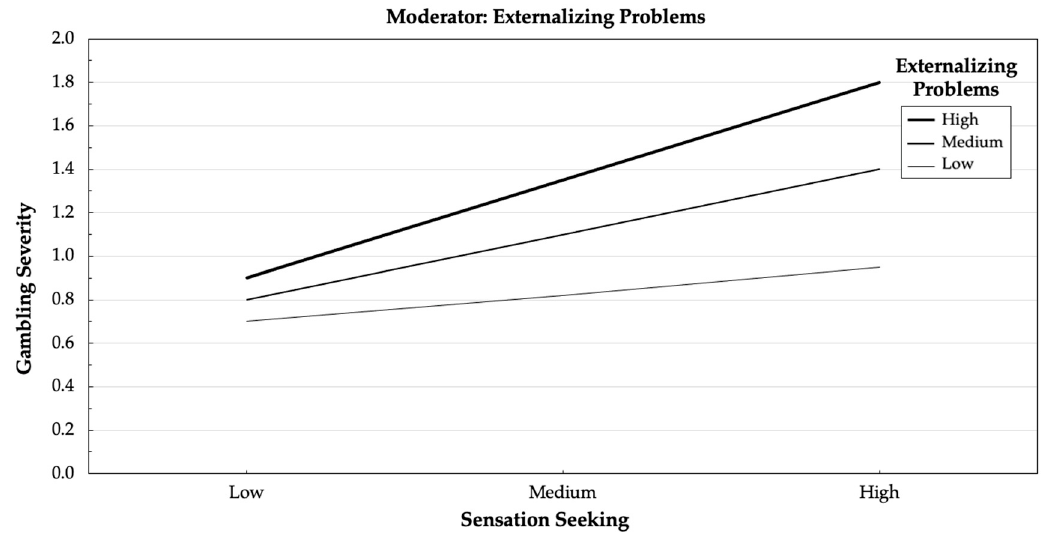
Figure 2. Interaction between sensation seeking and externalizing problems in the prediction of gambling severity.